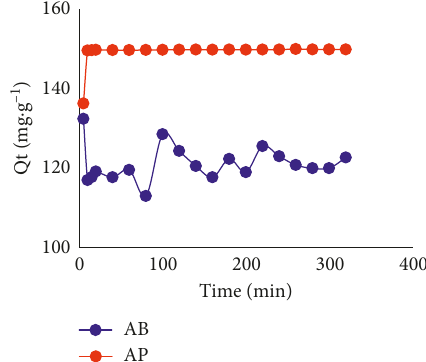
Figure 14: Adsorption kinetics of MG by Sejnane